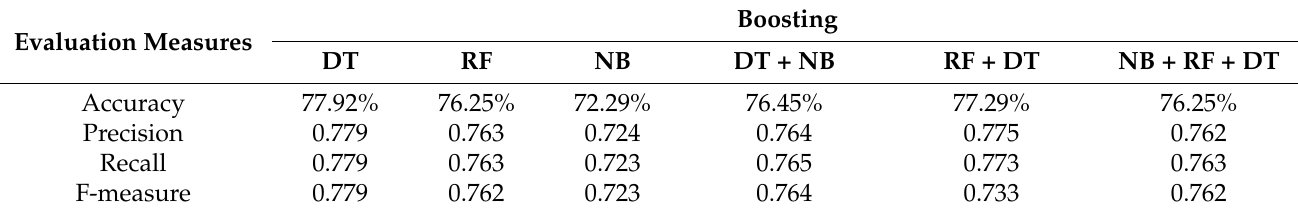
Table 3. Classification results with